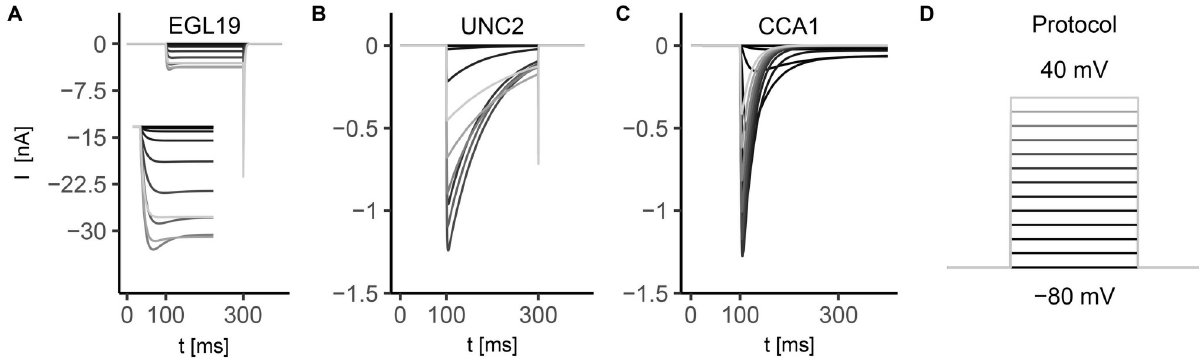
Fig 2. Simulated currents of voltage-gated calcium channels EGL1-9, UNC-2, and CCA-1. Calcium currents can be classified according to their activation voltage level: EGL19 and UNC2 currents activate at high membrane potential ( V > � − 40 mV), while CCA1 currents start to activate at low voltages ( V � − 70 mV) [15, 20, 36, 37, 75]. Stimulation protocol (sketched in panel D) consists in 10 mV voltage steps ranging from -80 mV to 40 mV. Each step lasts 200 ms, and is applied from a holding potential V = − 80 mV. The reversal potential for calcium is V = 60 mV. EGL19, UNC2, and h Ca CCA1 currents are given by Eqs B5, B10, and B14 in S1 File, respectively, in which � g ¼ 200 nS , � g ¼ 23 nS , and � g ¼ 25 nS (conductance EGL 19 UNC 2 CCA 1 values are chosen to match the currents of reference experimental data). The currents are expressed in nA, depending on the experimental data used as reference. A) EGL19 current . Experimental data for steady-state activation and inactivation variables from [15] and for activation and inactivation time constants from [36]. EGL19 current activates rapidly ( t � 6 ms at 0 mV) at high voltage ( V > − 30 mV, see S3 Fig). The voltage dependence of the m EGL 19 activation time constant is described by the sum of two Gaussian functions with shifted centers (Eq B2 in S1 File and S3 Fig), as in [76]. The steady-state inactivation function has a U-shape, with a minimum of about 0.5 at 0 mV (Eq B3 in S1 File and S3 Fig). The inactivation time constant voltage dependence is described by the sum of two sigmoids (Eq B4 in S1 File and S3 Fig), as in [76]. B) UNC2 current . Experimental data for steady-state activation and inactivation curves from [37], and for activation and inactivation time constants from [38] and [39], respectively. UNC2 current starts